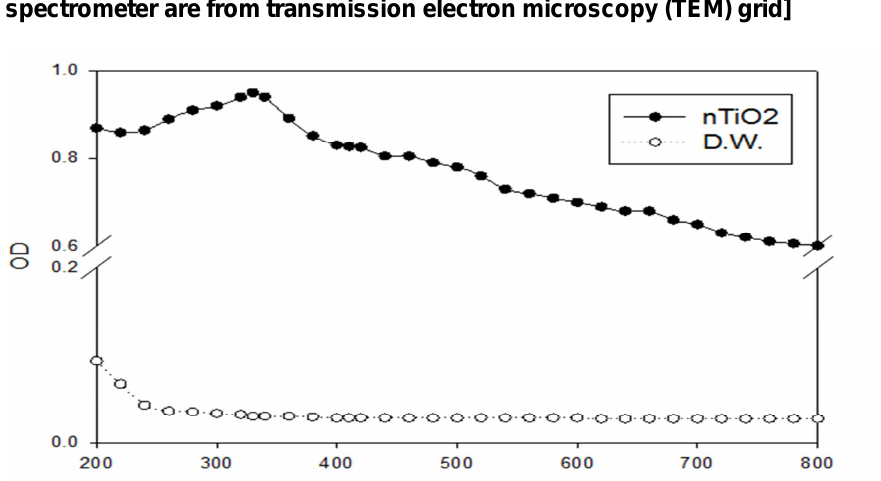
Figure 4. Energy dispersive X-ray (EDX) spectrometer patterns of dry titanium dioxide nanoparticles (nTiO ) powder [Ni signals in EDX 2 spectrometer are from transmission electron microscopy (TEM) grid]